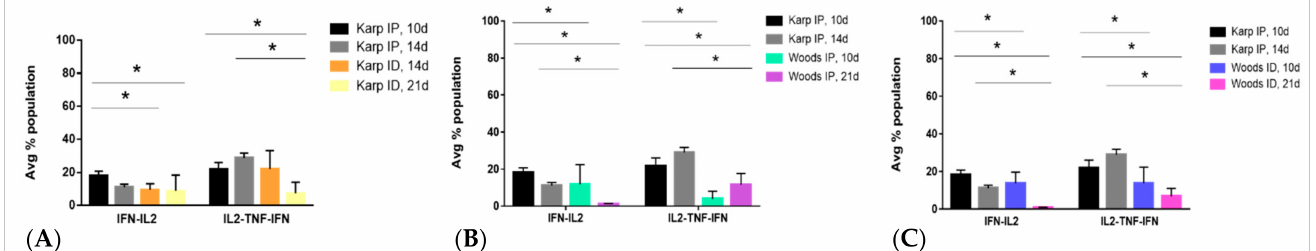
Figure 7. CD4 lethal cytokine signature. ( A ) Intrastrain comparisons revealed significant increase in IFN-IL2 production in the lethal model at 10 dpi compared to the nonlethal models at 14 and 21 dpi; significant increases in IL2-TNF-IFN production were observed in the lethal model at 10 and 14 dpi compared to the nonlethal model at 21 dpi. ( B , C ) In both interstrain comparisons, significant increases in IFN-IL2 and IL2-TNF-IFN were observed in the lethal model at 10 and 14 dpi when compared to nonlethal models at both 10 and 21 dpi. Significant differences between average cytokine populations in the lethal and nonlethal models are indicated by asterisks (*, p <